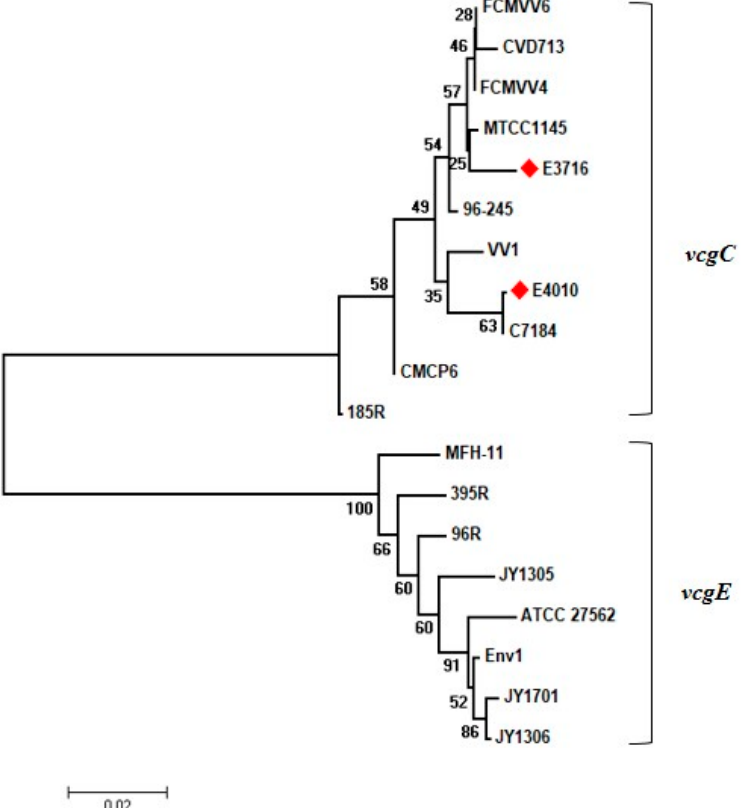
Figure 2. Phylogenetic analysis of the vcg alleles of V. vulnificus . Phylogeny was estimated by the Neighbor-joining method ( p -distance) using the sequence information obtained from the NCBI. Numbers in the phylogenetic tree are the representation of percentages of bootstrap support from 1000 replicates. E3716 and E4010 are representative seafood isolates obtained in this study.